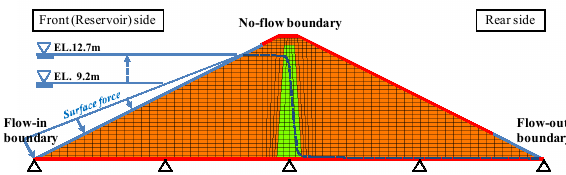
Fig. 8. Soil-water characteristic curve and specific permeability curve for each